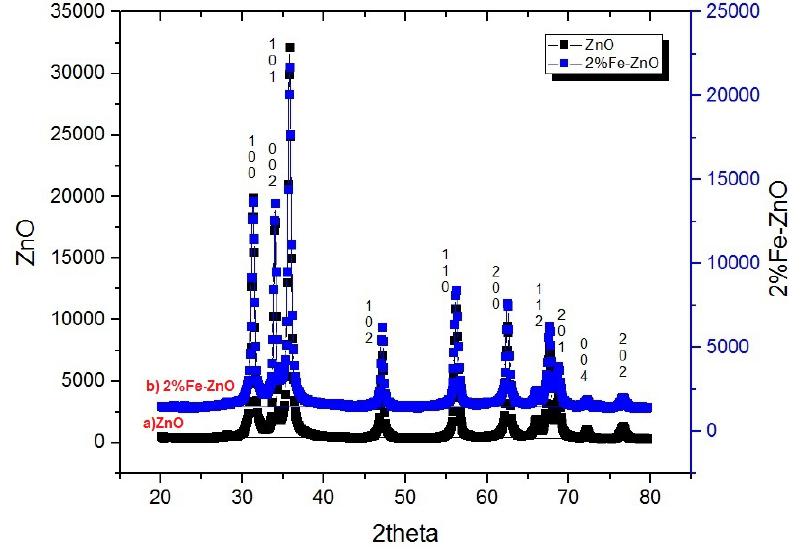
Fig. 4. XRD pattern of nanoparticles ZnO and 2% Fe-ZnO Fig.4. XRD pattern of nanoparticles ZnO and 2% Fe-ZnO Table 3 Pseudo-first-order rate constant of MB for Photocatalytic degradation Table 3. Pseudo-first-order rate constant of MB Photocatalytic degradation